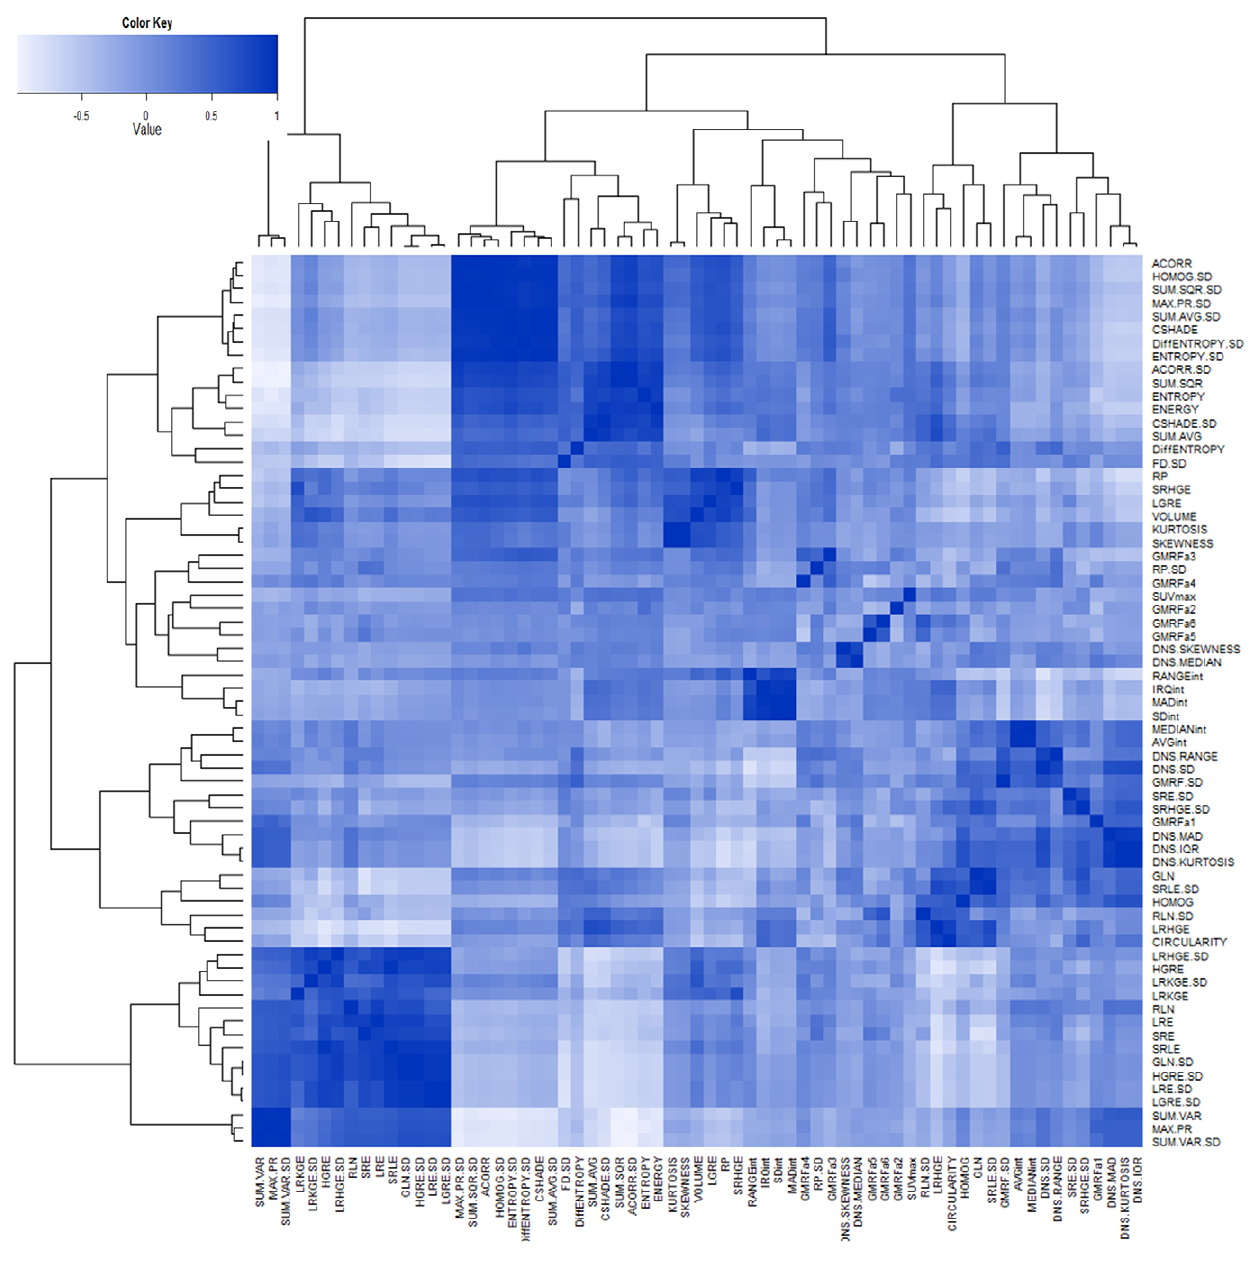
Figure 5. Hierarchical clustering is used based on the correlation of all data at hand. A correlation matrix together with clustering (i.e., Pearson uncentered) of the feature points is presented from R= 2 1 negative correlation (white) to R=1 positive correlation (blue).